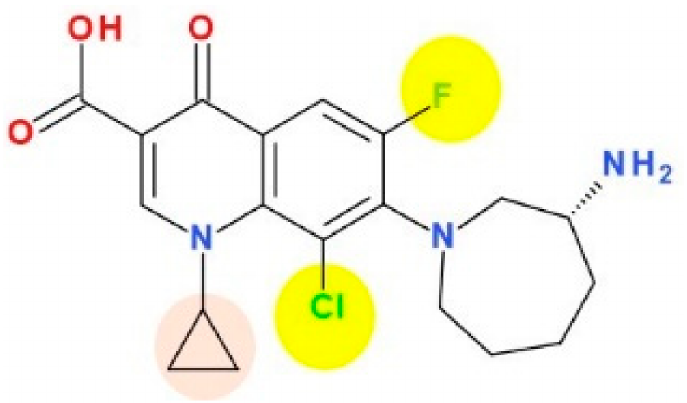
Figure 5. Chemical structure of